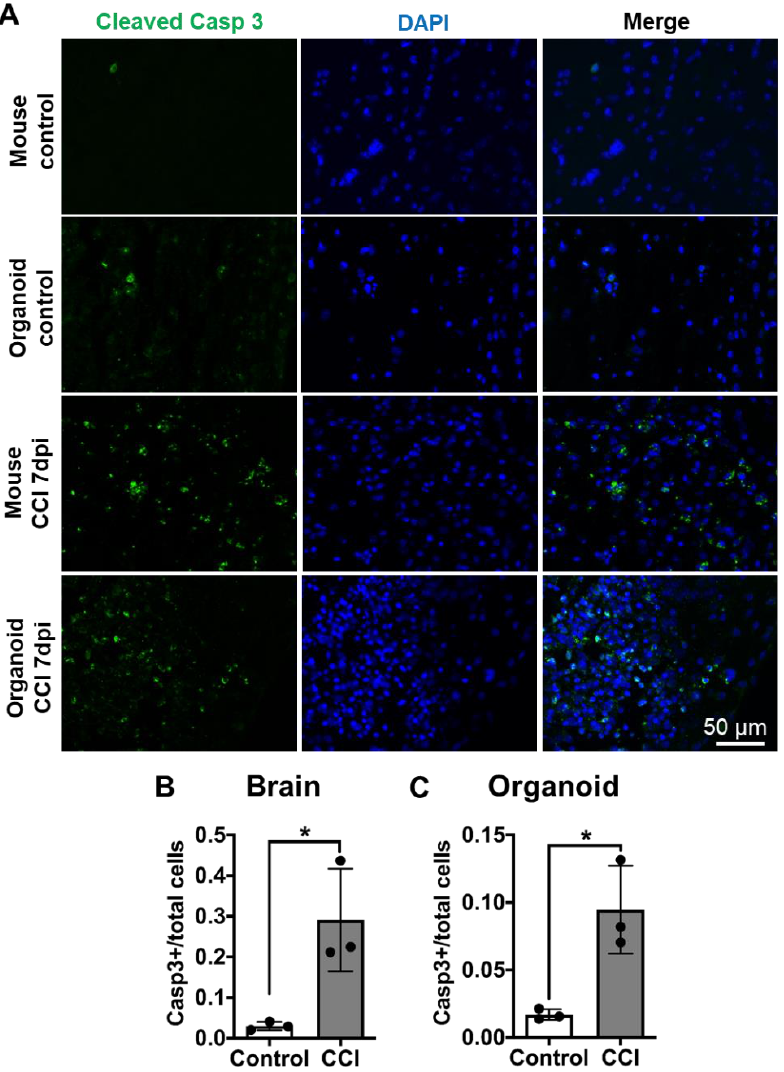
Figure 5. CCI-induced apoptosis in COs. ( A ) To analyze the induction of apoptosis, we immunostained sections from mouse brain and COs with an antibody raised against cleaved caspase 3, a well-established marker of apoptosis. Mouse brains were analyzed across the impact zone and penumbra. ( B ) Significant increase in cleaved caspase 3 in mouse brain after CCI compared to control. ( C ) Similarly, CCI significantly increased NSE accumulation in COs compared to sham control, indicating neuronal damage. Statistical analysis performed with Student’s t -test, * p ≤ 0.05.